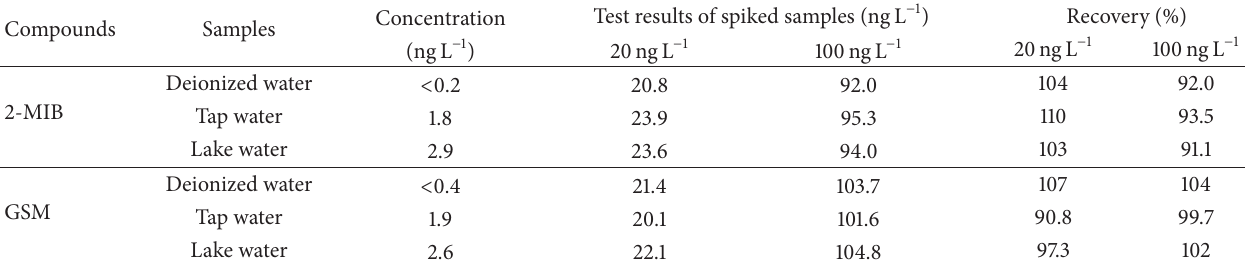
Table 9: The recovery of environmental